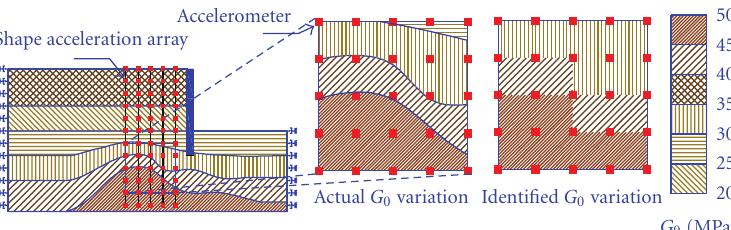
Figure 16: Sample results of a numerical simulation conducted to show the potential of using shape acceleration arrays (SAAs) to identify locally the low-strain mechanical properties of multilayered sites or other complex soil systems